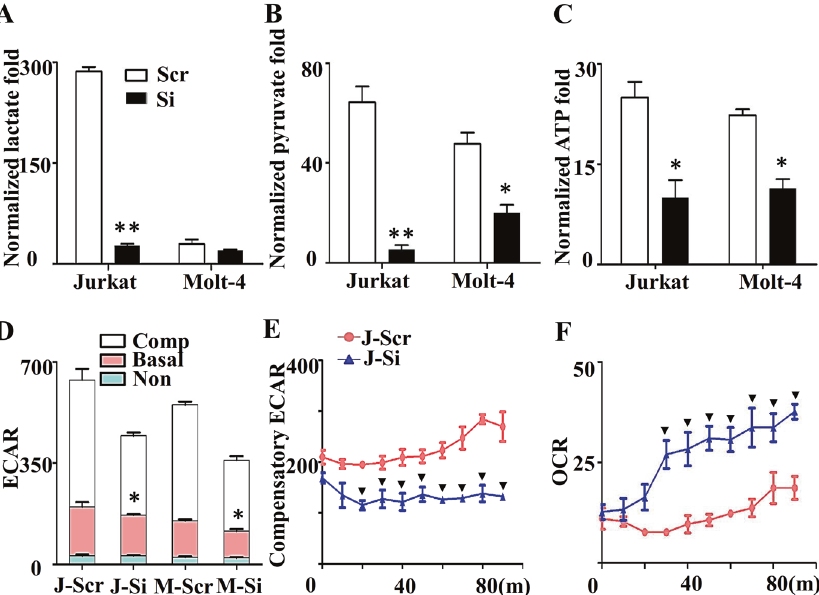
Fig. 2 The role of miR-652-5p in glycolysis of T-ALL cells. Gas Chromatography-Tandem Mass detected ( A ) the lactate content, ( B ) pyruvate content, and the value was normalized to internal control. ( C ) Effect of impaired miR-652-5p on the production of ATP. ( D ) Extracellular acidi fi cation rate (ECAR) at end point, ( E ) Continuous monitoring compensatory ECAR, and ( F ) Oxygen consumption rate (OCR) were detected by fl uorescence microplate analyzer. m minutes, J Jurkat cell lines, M Molt-4 cell lines, Scr control, Si impaired miR-652-5p, ECAR extracellular acidi fi cation rate, OCR oxygen consumption rate. Non, the ECAR from non-glycosis; Comp, compensatory glycosis from stimulation with oligo. p is compared to control and calculated by t student; * p < 0.05; ** p < 0.01., indicated the signi fi cance at certain time point, compared to control, p <